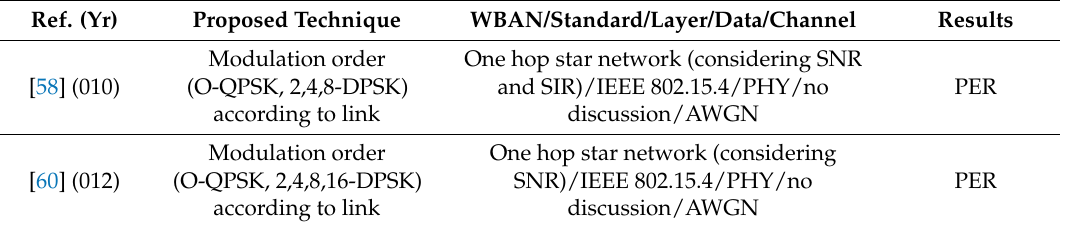
Table 8. A review of modulation based